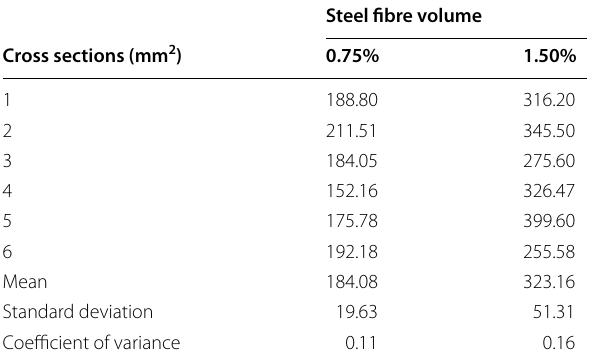
Table 6 SF Area determined through photogrammetry analysis (mm 2 )